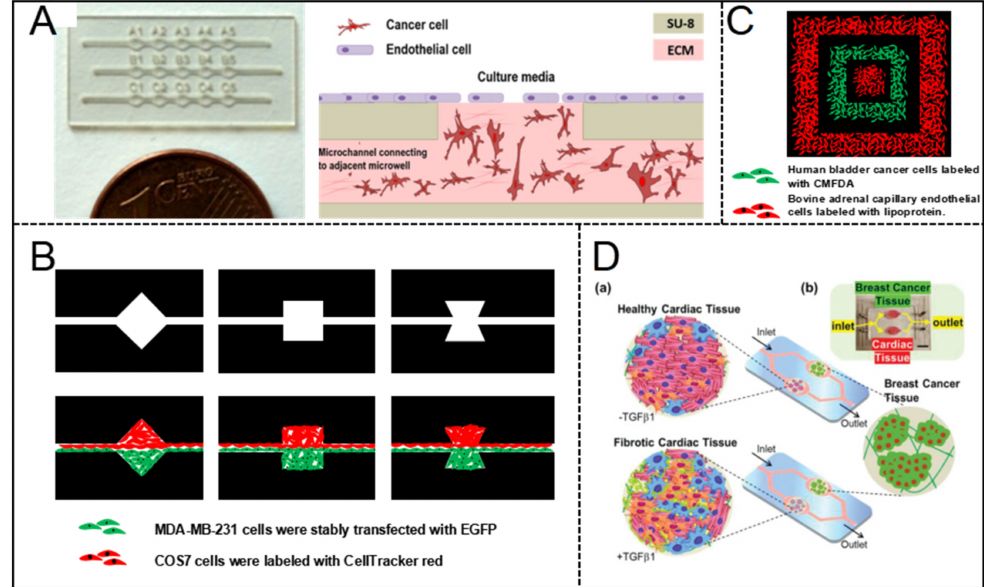
Figure 4. Designable patterned co-culture model in breast tumor-on-a-chip. ( A ) The co-culture of a 3D breast tumor model and a 2D endothelium model in a multiwell capillarity-based microfluidic device [48]. Open access. ( B ) Patterned spheroids of various geometries and compositions were formed to manipulate cell-cell interaction dynamics [49]. Adapted from [49], Data from [49]. ( C ) A concentric square was patterned by two cell types and proteins in a 3D microfluidic system [50]. Adapted from [50], Data from [50]. ( D ) A dual-organ platform of breast and heart were fabricated in microfluidic chip to investigate the chemotherapy-induced cardiotoxicity [51]. Open